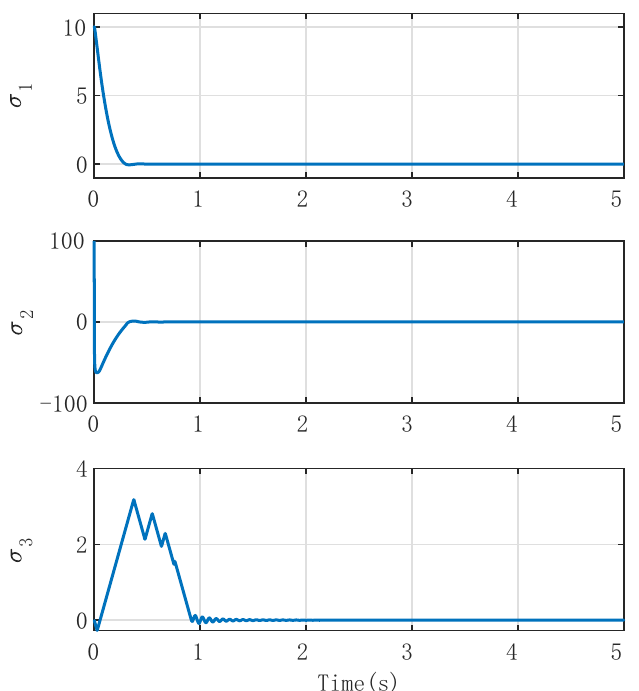
Figure 3. Proposed 3-ISMC control: Time histories of σ 0 , σ 1 , and σ 2 corresponding to initial condition of σ ( 0 ) =[10, 100,